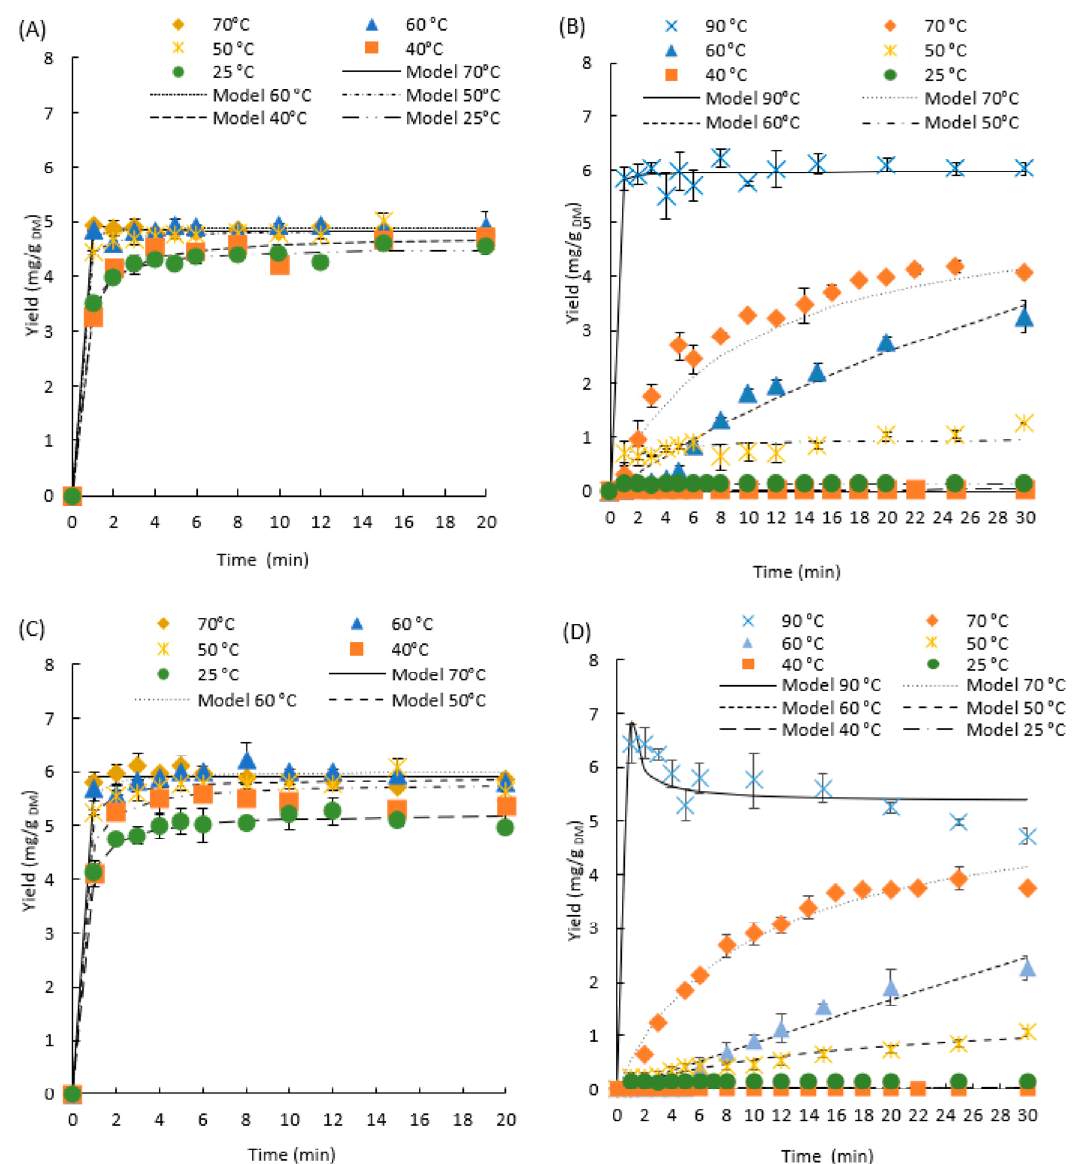
Figure 4. Effect of the temperature of extraction on the kinetics of the extraction of 3- O -CQA in 70% ethanol ( A ) and water ( B ) and 3,5- O -di-CQA in 70% ethanol ( C ) and water ( D ). (symbols—experimental yields; lines—approximation